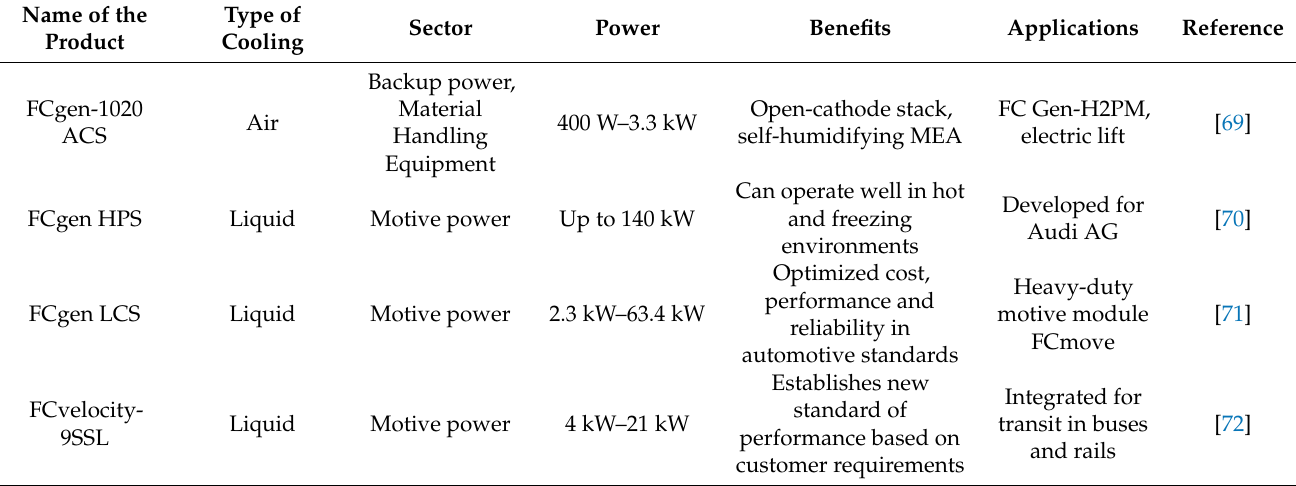
Table 9. Commercial fuel cell stack units of Ballard